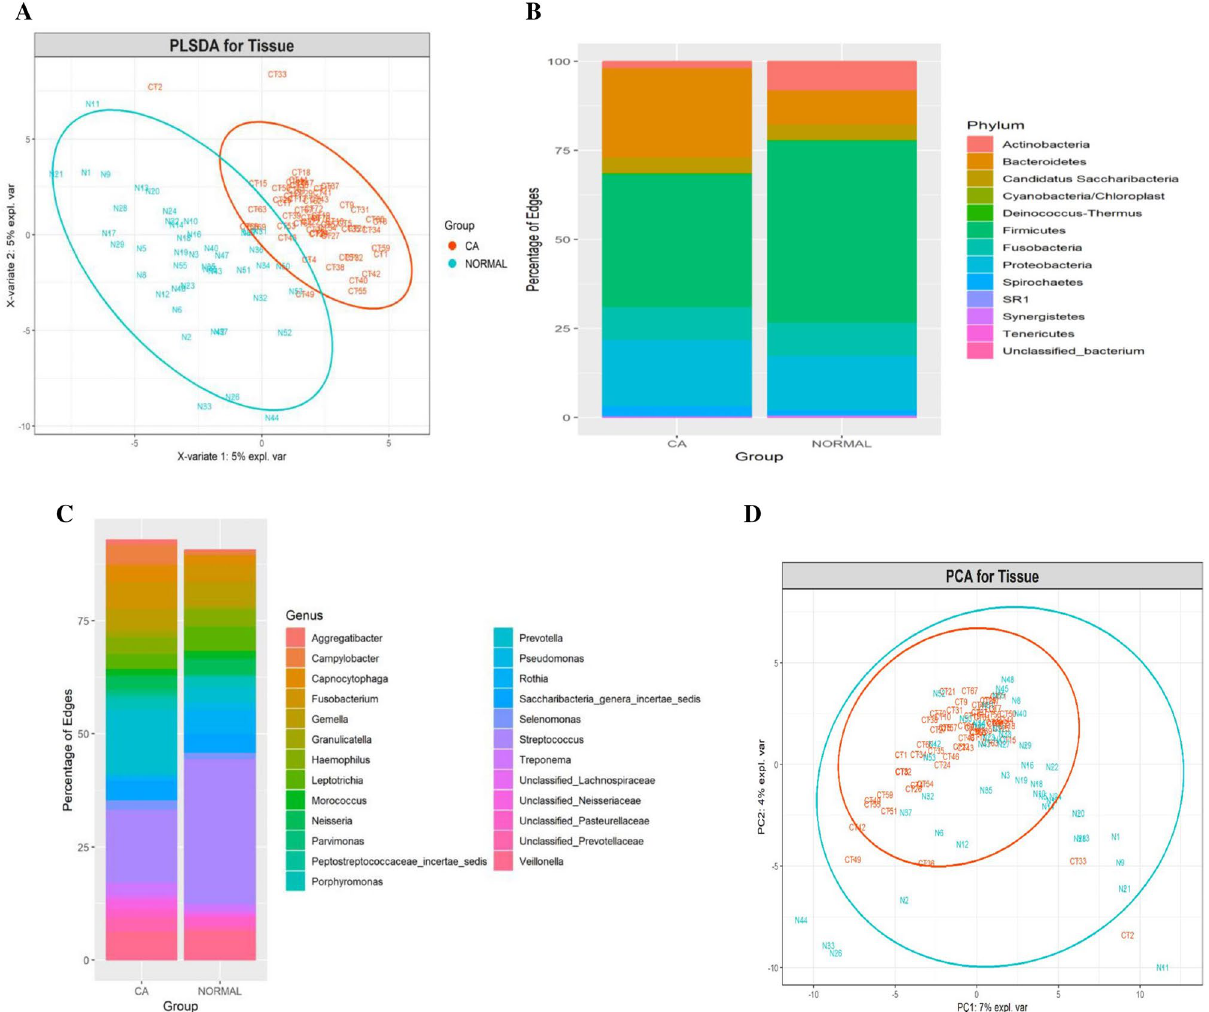
Figure 1. ( A) PLS-DA plot of oral microbiota between the cancer (CA) tissues and normal tissue sample (P < 0.01). P value was determined by PERMANOVA. Percentage distribution of bacterial communities across samples in CA and normal tissues at the phylum (B) and genus (C) levels. ( D) PCA